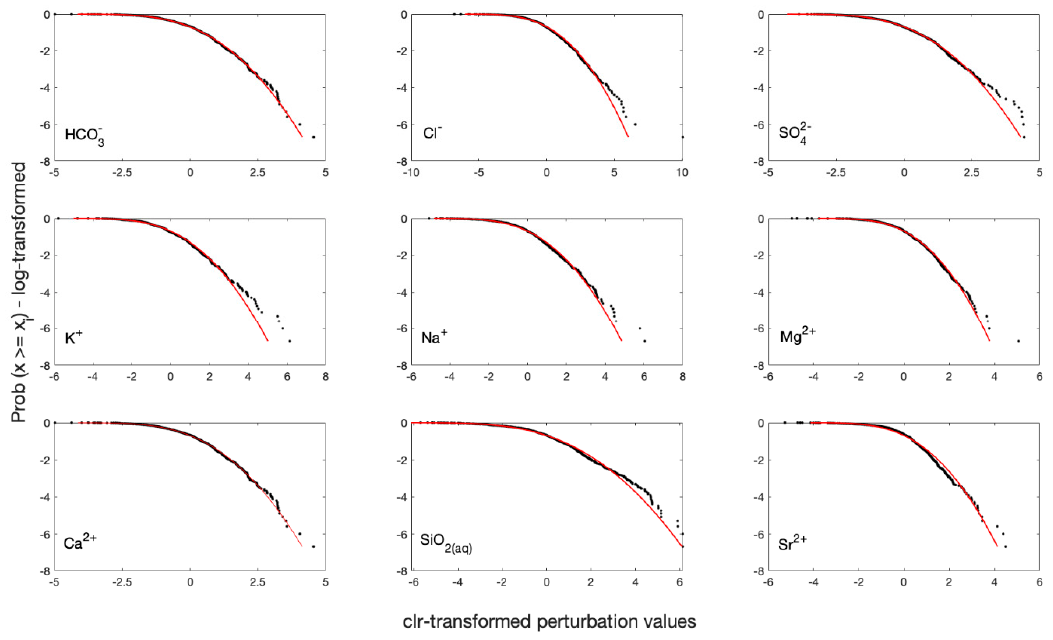
Figure 5. Complementary cumulative distribution function N >= x versus x in log–log coordinates for clr-perturbation-subtraction values. The log-normal model is represented by the continuous curved line.